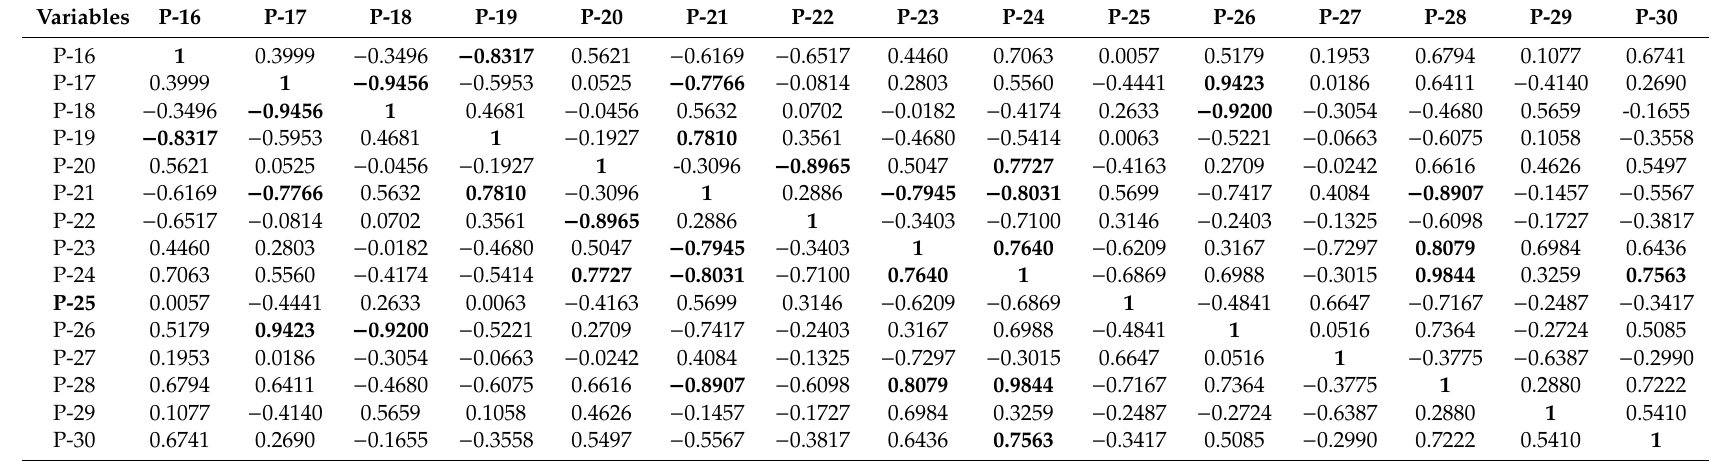
Table 6. Correlation between wheat malt quality indicators and limit of attenuation (Pearson correlation